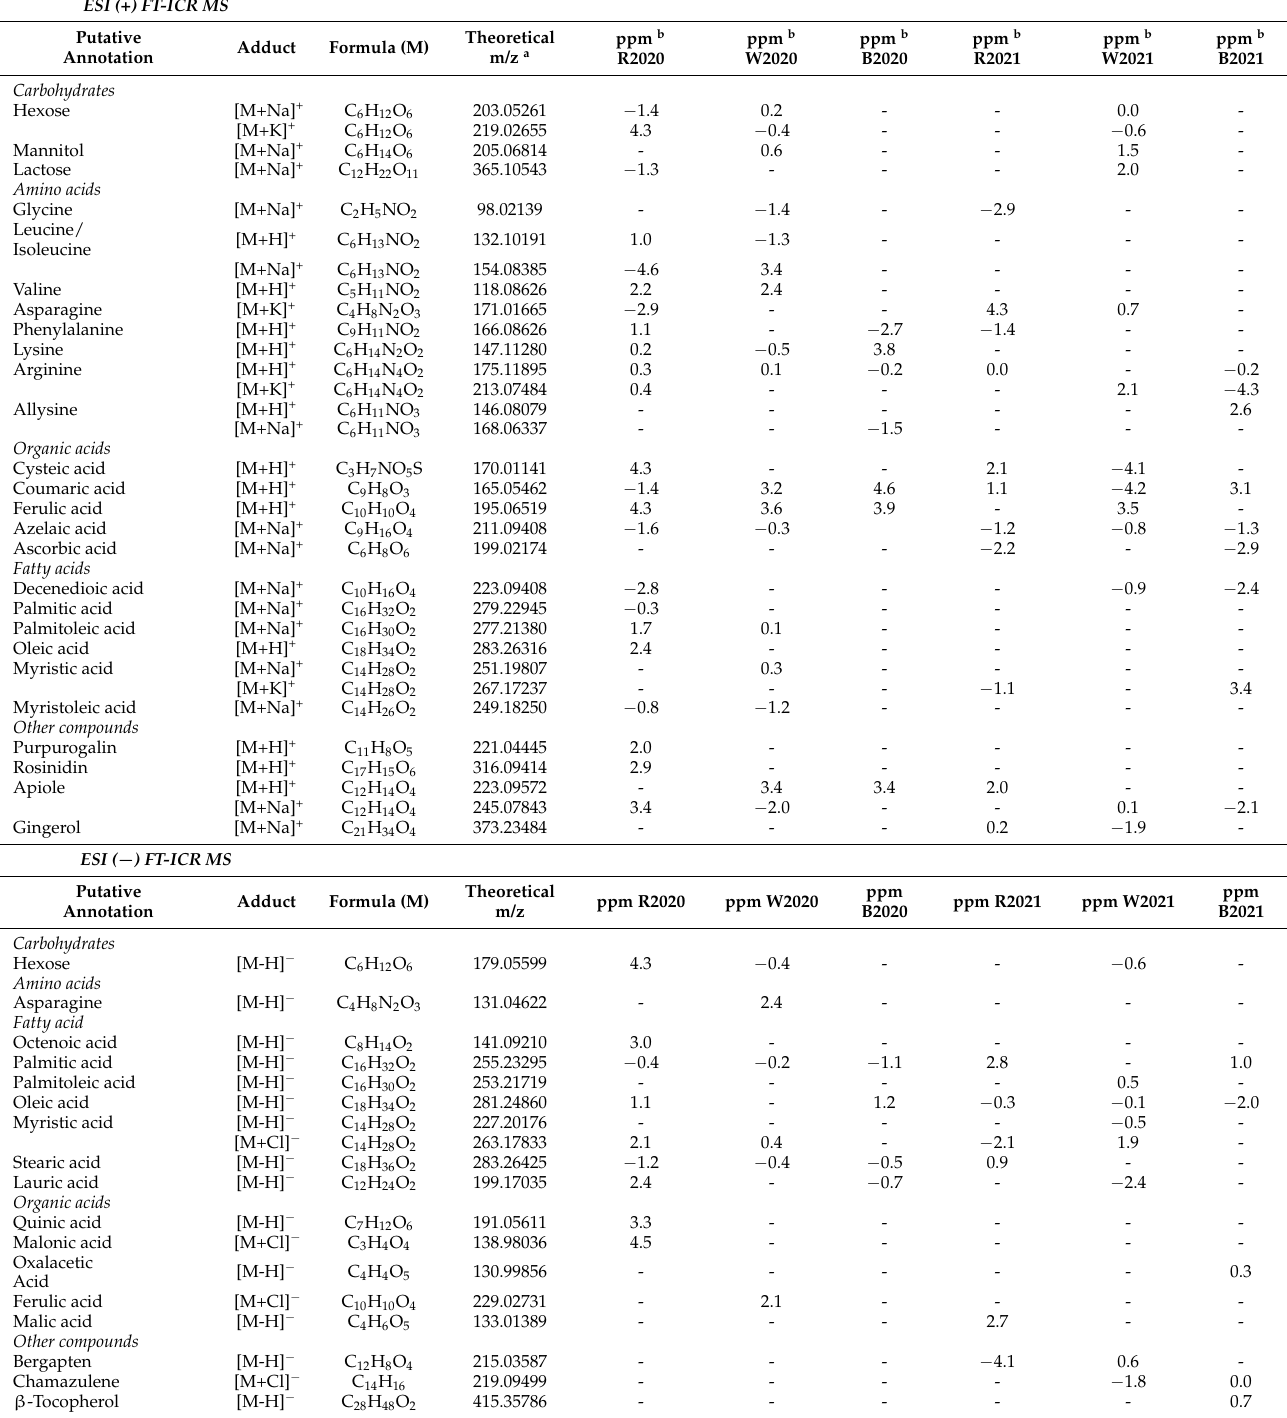
Table 1. Major metabolites in hydroalcoholic extracts of red and white tunicae and bulb of ‘Sulmona red garlic’ collected in 2020 and 2021 and revealed by ESI FT-ICR